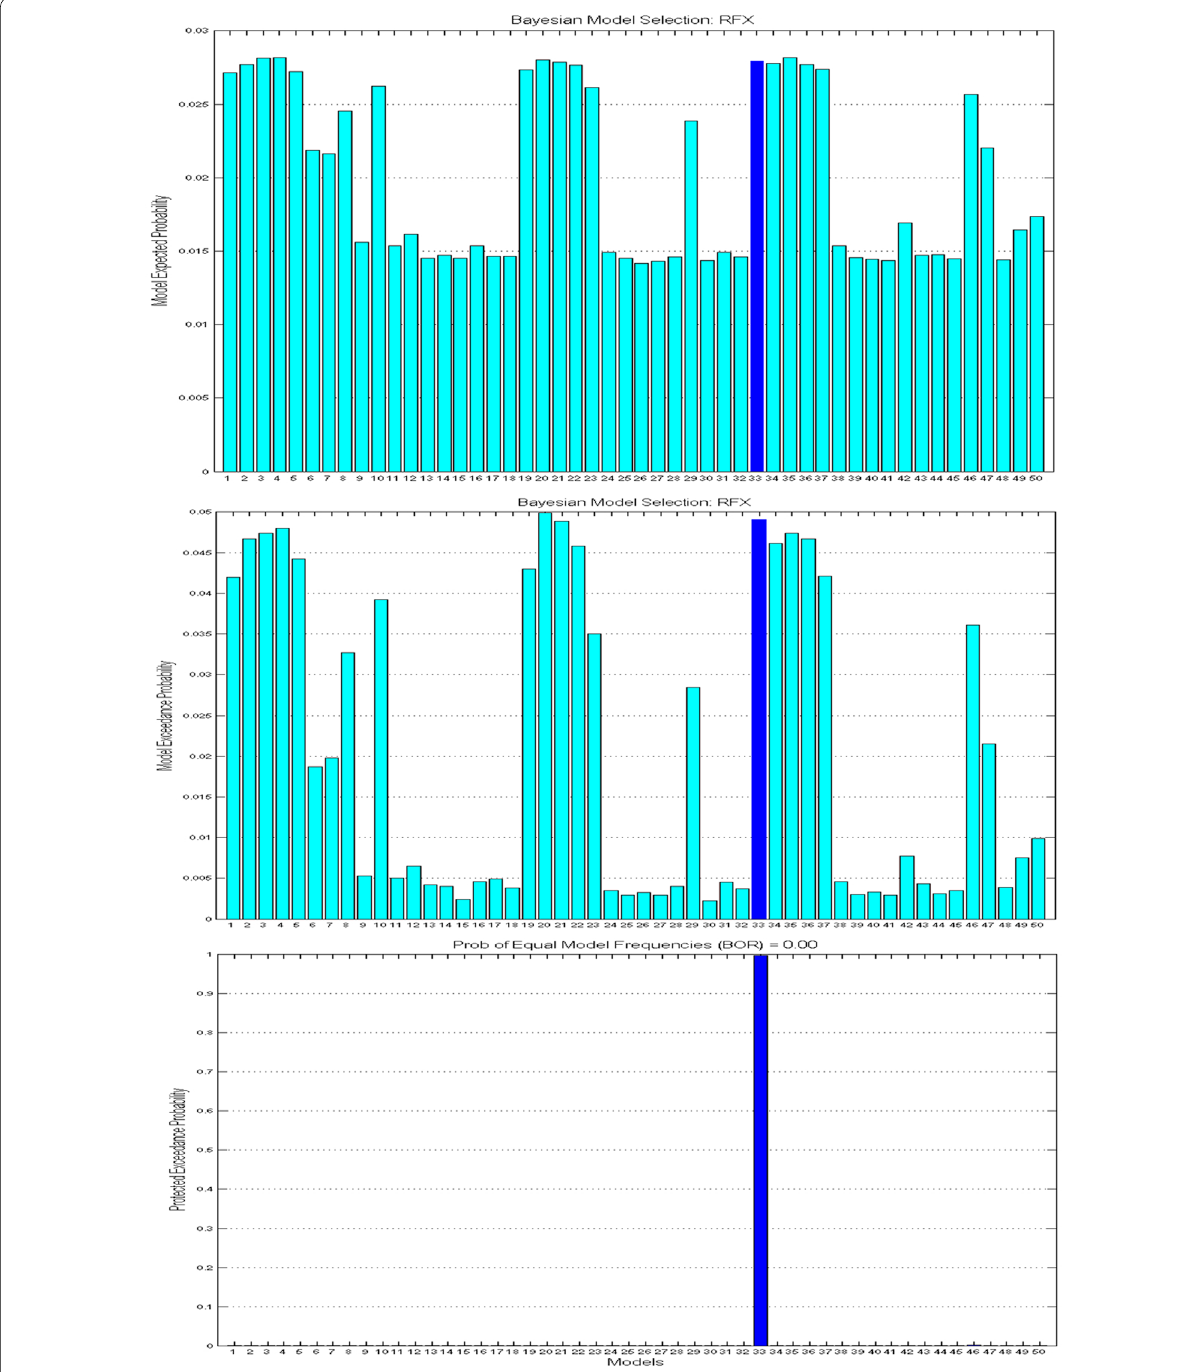
Fig. 2 Results of the model comparison revealed by the Bayesian model selection, over the 50 pre-defined models of emotion regulation constructed on the basis of classic theories or the new hypotheses. The 33rd model won the comparison, and was recognized as the optimal